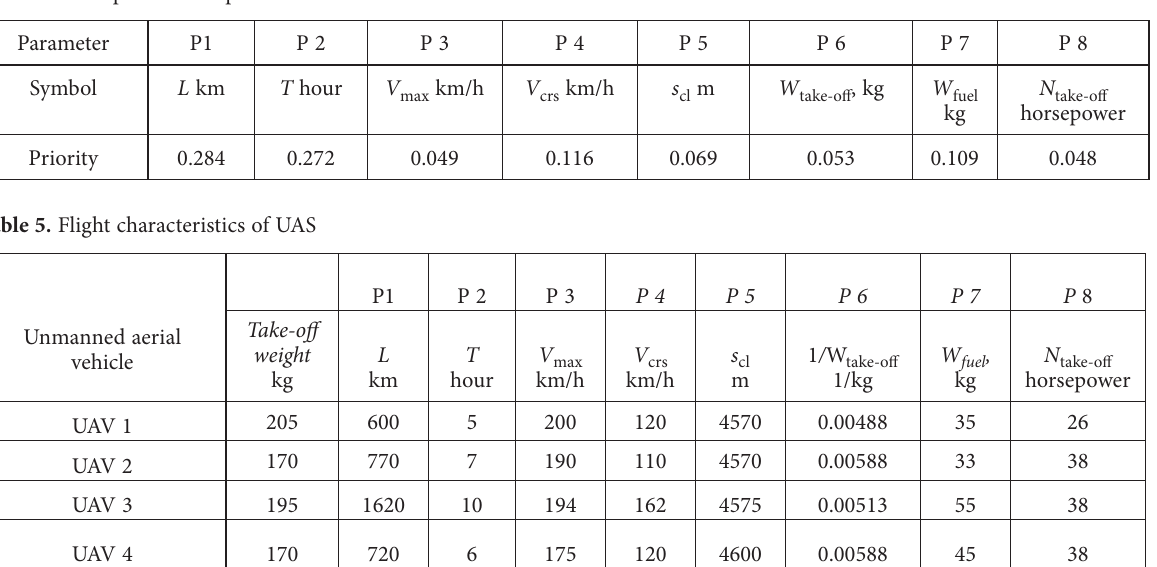
Table 6 is formed by means of dividing each ele- ment of column P1 of table 5 by the values of UAVs (1–4) parameters that are located in the same column. As a res- ult, we have got matrix L (size 4 × 4) given in table 6.